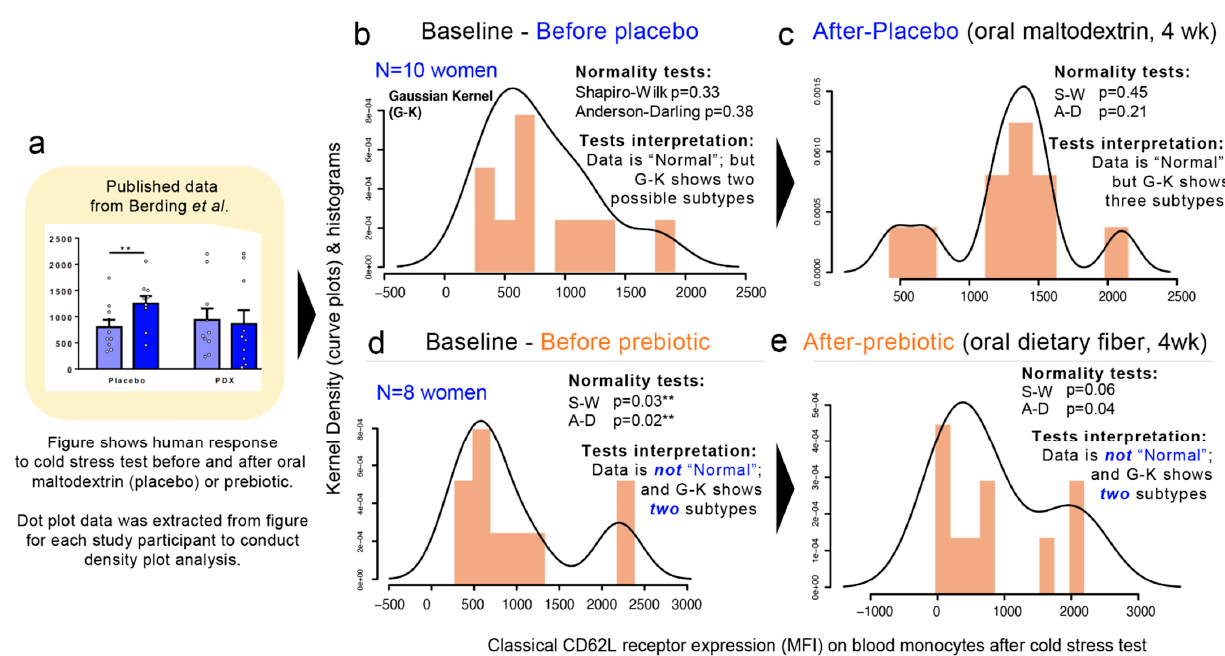
Figure 8. Example of multimodality in human outcome data. ( a ) Data was extrapolated from dot plot in study published by Berding et al . [87] ( b,c ) Outcome data for “placebo” maltodextrin group before and after cold stress test. ( d,e ) Outcome data for “prebiotic” fiber group before and after cold stress test. Panels B and D illustrate that two different groups of individuals sampled for the study have different degrees of susceptibility. Asterisks indicate significance P < 0.05.